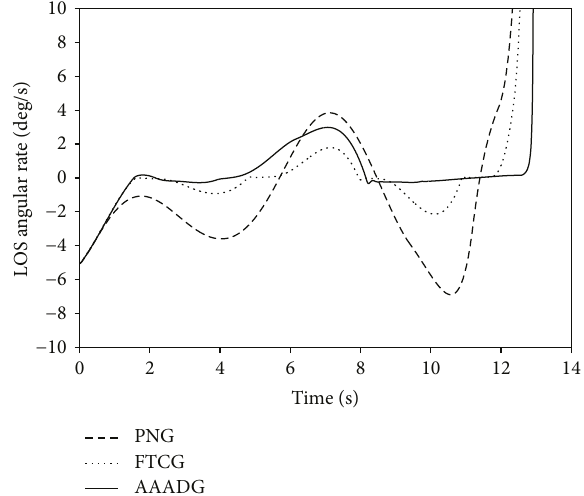
Figure 3: LOS angular rates under three guidance